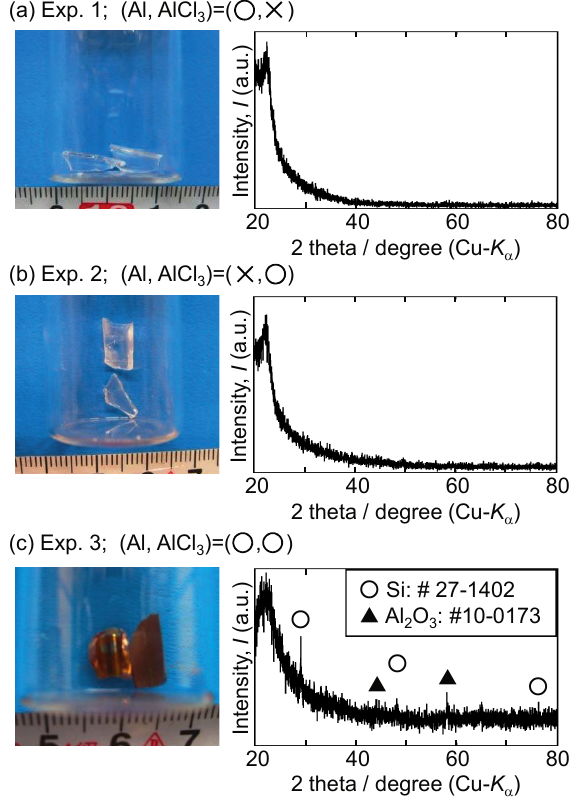
Figure 9. (a) Exp. 1, (b) Exp. 2, and (c) Exp. 3.